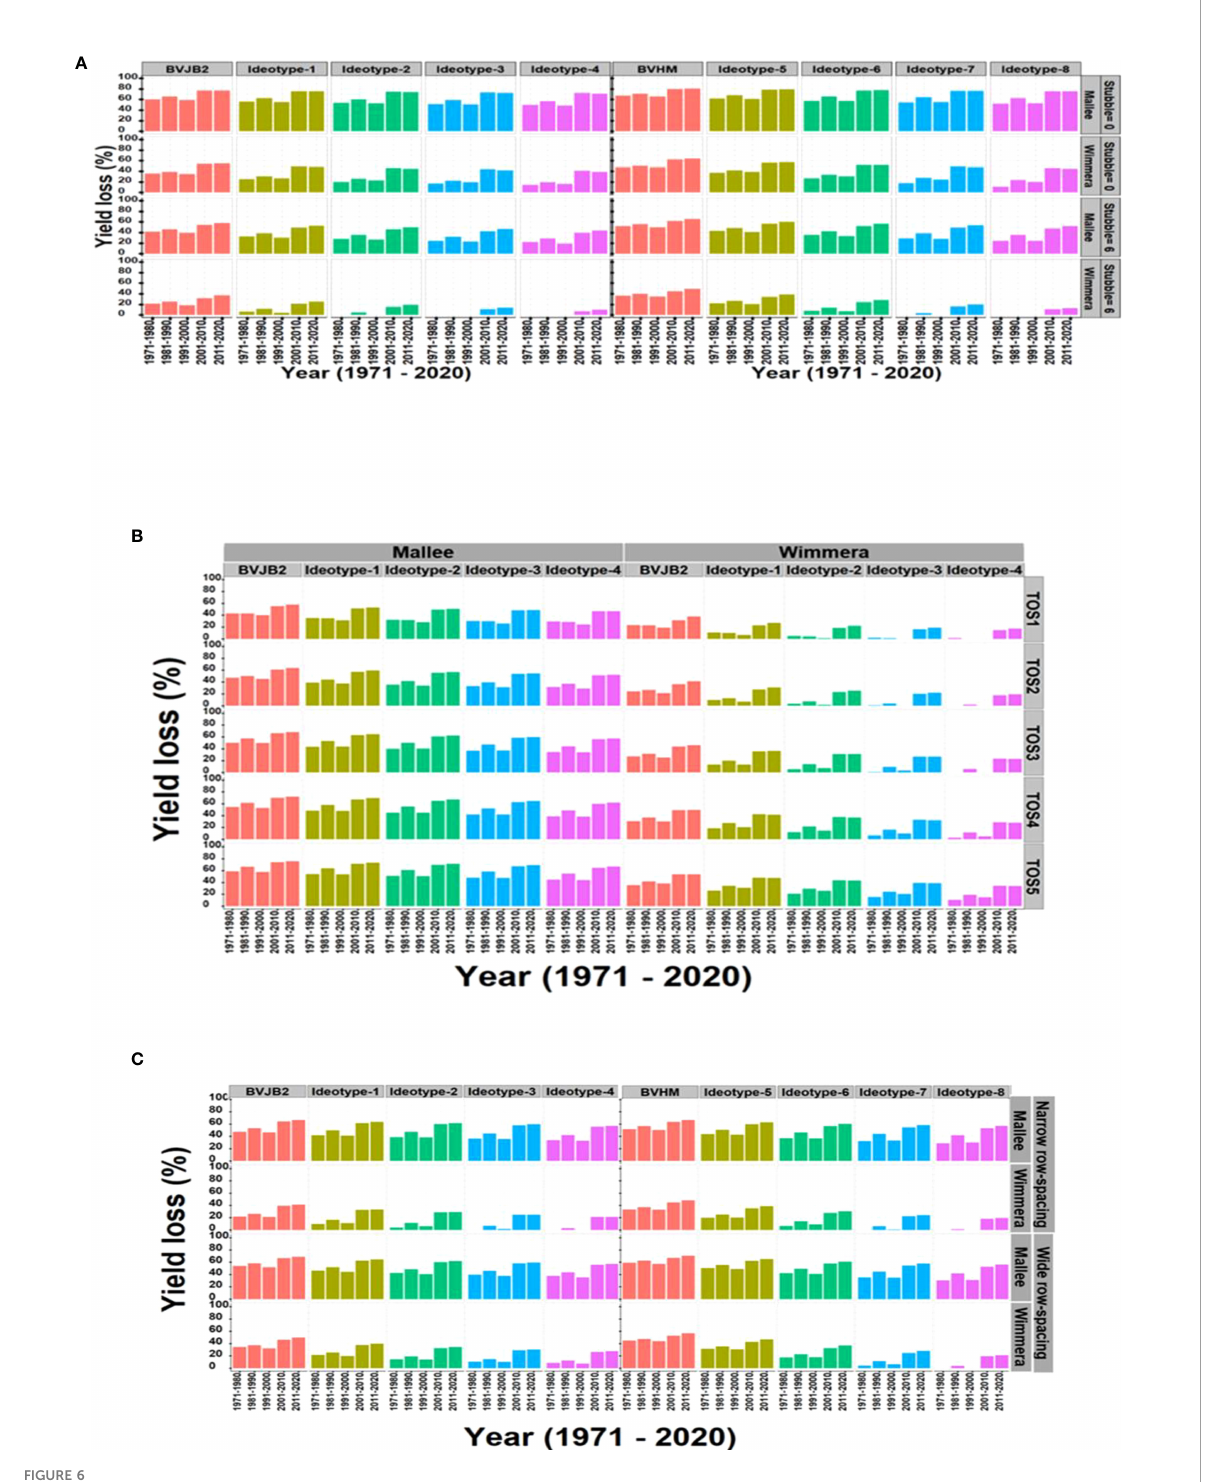
FIGURE 6 The synergies between ideotype and agronomic practices viz., stubble retention (A) , time of sowing (B) and row spacing (C) to reduce yield loss between 1971 and 2020 in low rainfall (Mallee) and medium rainfall (Wimmera) environments. Yield loss (%) was estimated in terms of average per decade. BVJB2, Baseline variety Jumbo2; BVHM, Baseline variety Hallmark; Ideotype was created by a ten percent increase (10%-40%) of individual trait (leaf size, RUE and HI rate) around baseline varieties; Ideotype 1 to 4 used genetic background of Jumbo2 and 5 to 8 used Hallmark; TOS, time of sowing. TOS1=April 28, TOS2=May 12, TOS3=May 26, TOS4=June 7, TOS5=June 23; Stubble treatments were 0 and 6 t/ ha of initial surface residue of